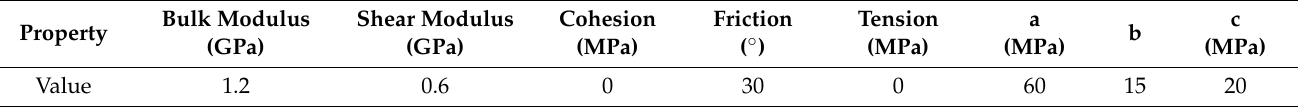
Table 3. Gob Material